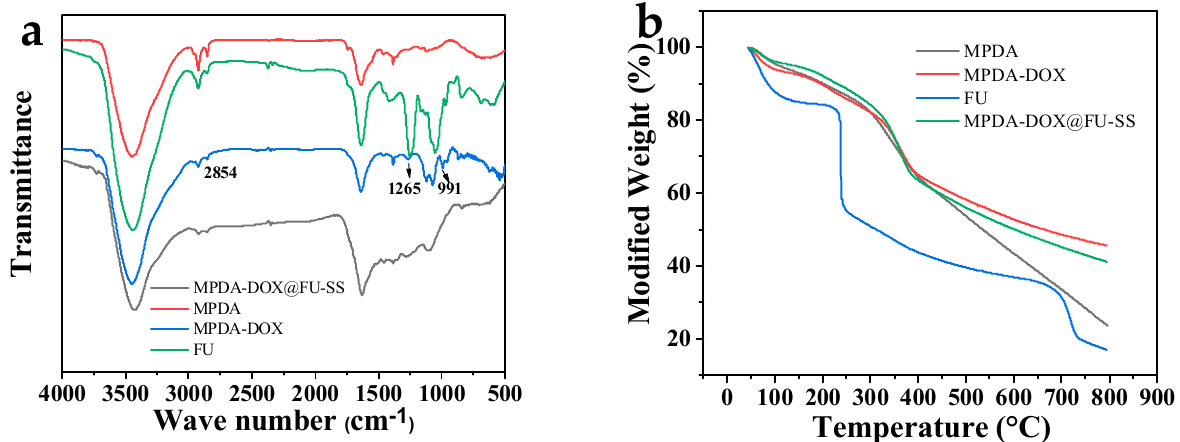
Figure 4. ( a ) Fourier transform infrared spectra and ( b ) thermogravimetric analysis of MPDA, FU, MPDA-DOX, and MPDA-DOX@FU-SS.